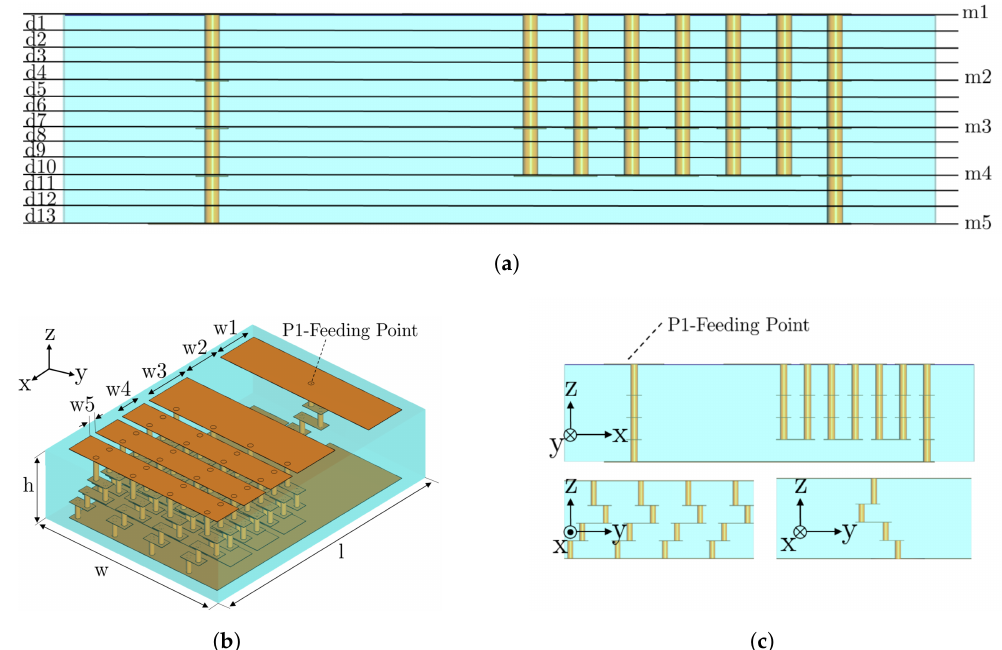
Figure 1. Geometry of the proposed low-profile LTCC chip antenna. Blue color represents the ceramic substrate, and orange color is the metallic layers and vias. ( a ) Side view with all LTCC layers specified, ( b ) overall view of the antenna (dimensions in Table 2), and ( c ) side views of the antenna. Table 2. Dimensions of the proposed chip antenna (unit: